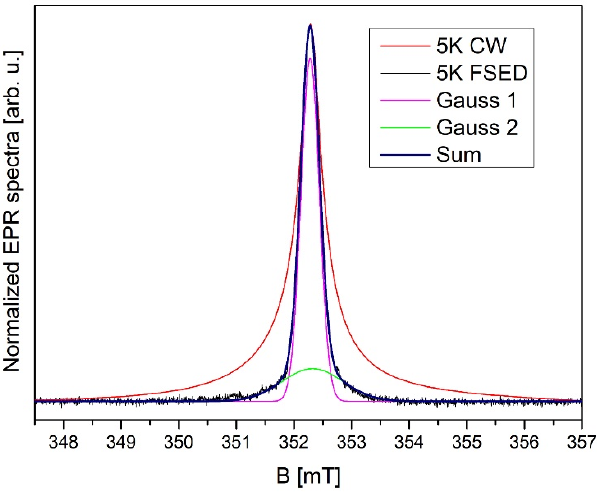
Figure 7. Comparison between continuous wave (CW)-EPR and field-swept echo-detected spectrum (FSED) and its decomposition into two components at 5 K.